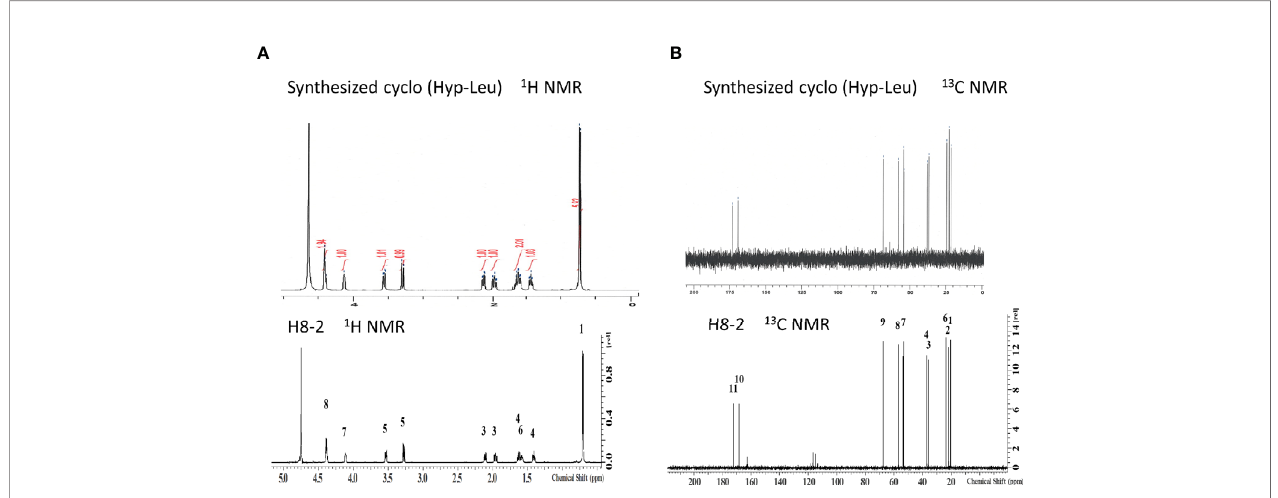
FIGURE 5 | Structure con fi rmation by NMR. (A) 1 H-NMR spectrum of synthesized cyclo (Hyp-Leu) was matched to that of H8-1, (B) 13 C-NMR spectrum of synthesized cyclo (Hyp-Leu) was matched to H8-1 13 C NMR.